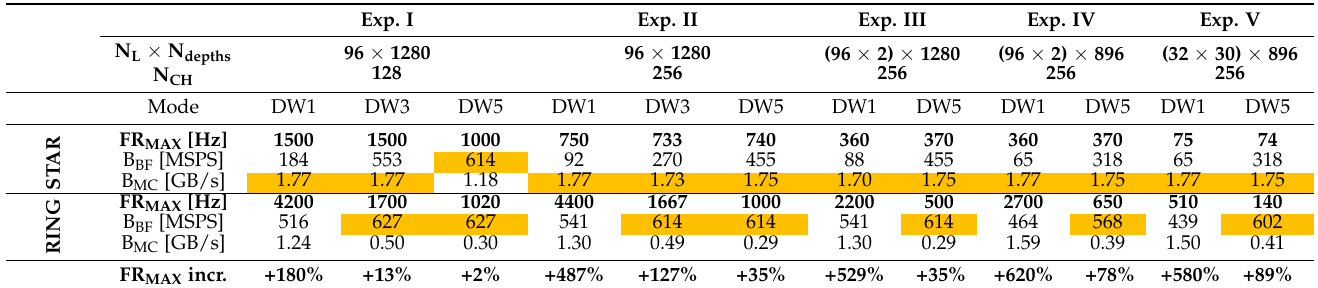
Table 3. System performance achieved during experiments I–V. Exp.